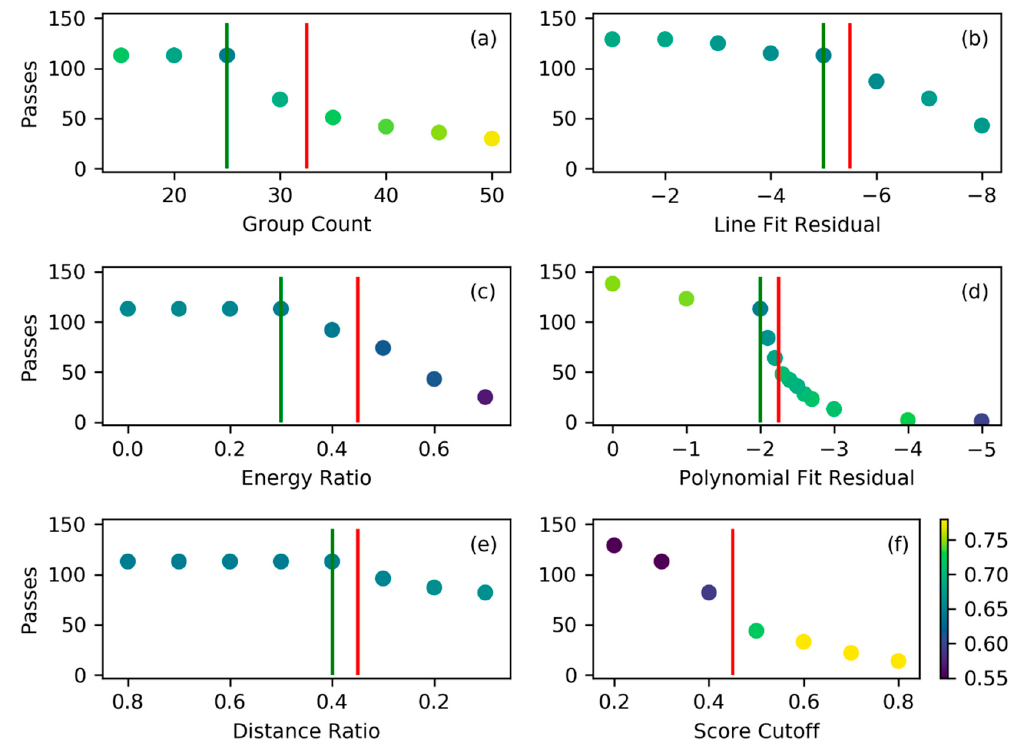
Figure 12. Filter effect on number of bolide candidate passes. The plots are oriented such that the filter parameters further to the right correspond to a more restrictive filter setting. The green line indicates the baseline filter setting. The red line marks the filter parameter step when a known true positive bolide signature was filtered out from the evaluation subset corresponding to an overly restrictive filter setting. The color shading of the points corresponds to the mean bolide score in the passed instances (colorbar shows score values). The shown filters are group count ( a ), line fit ( b ), energy ratio ( c ), polynomial fit ( d ), distance ratio ( e ), and cumulative bolide score cutoff ( f ).